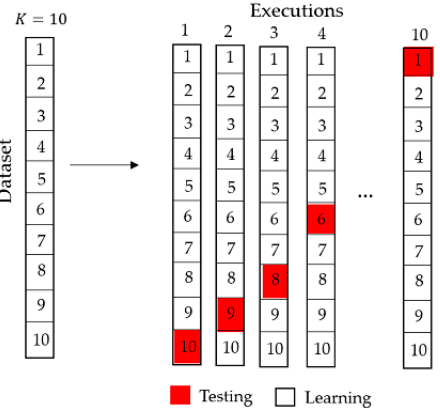
Figure 3. Operation of the 10-fold stratified cross validation method.